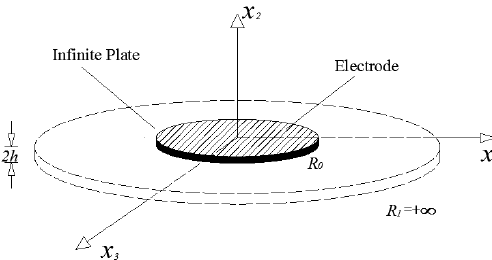
Figure 1. A centrally partially-electroded circular AT-cut quartz plate.